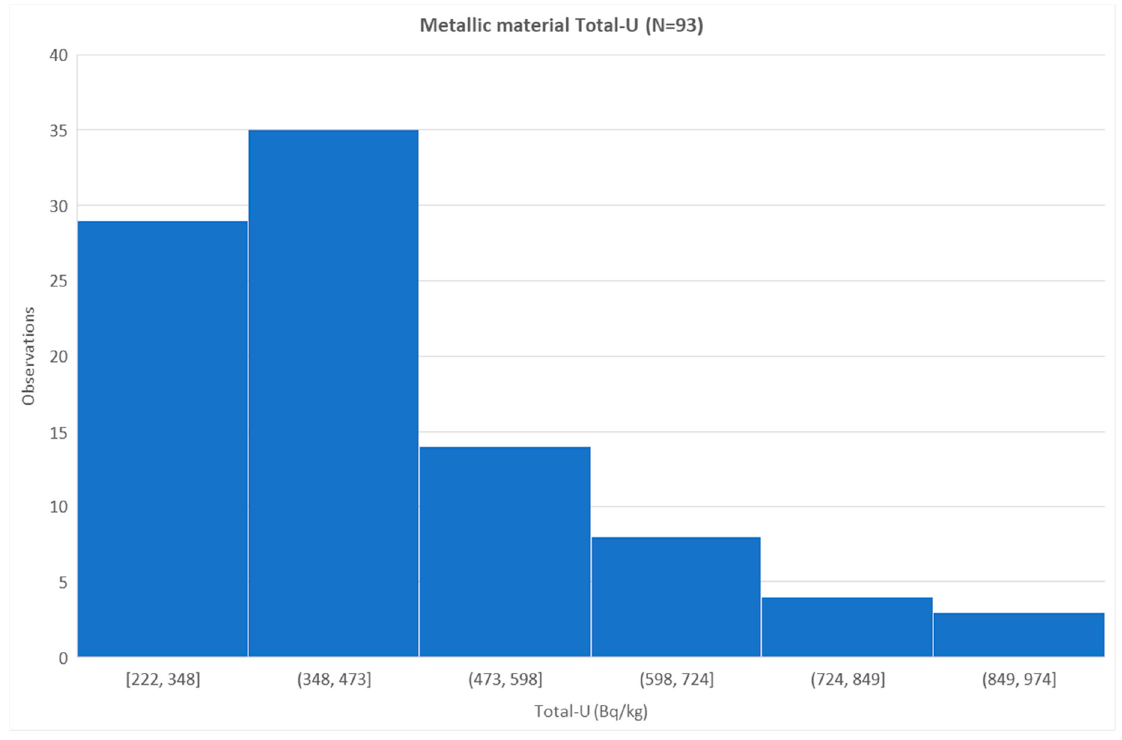
Figure 3. Performed radiometric measurements on metallic materials to be cleared from Bosco Marengo “FN” nuclear installation. Environments 2019 , 6 , x FOR PEER REVIEW